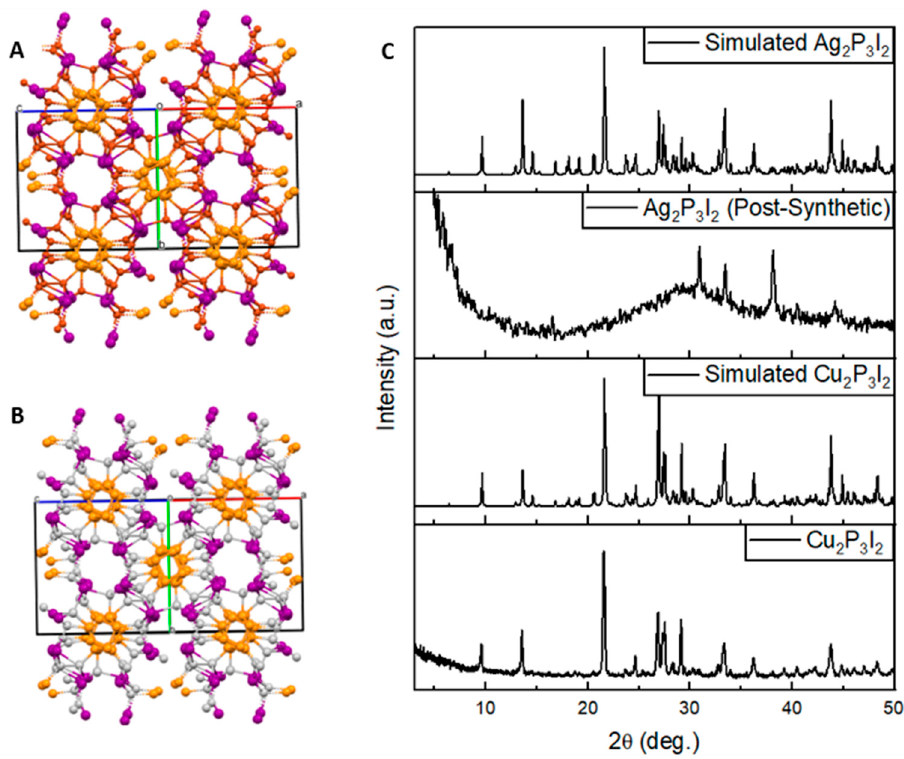
Figure 3. Crystal structures of Cu 2 P 3 I 2 ( A ) and the modified isotypic Ag 2 P 3 I 2 ( B ) as well as their corresponding PXRD predicted and experimental patterns ( C ).